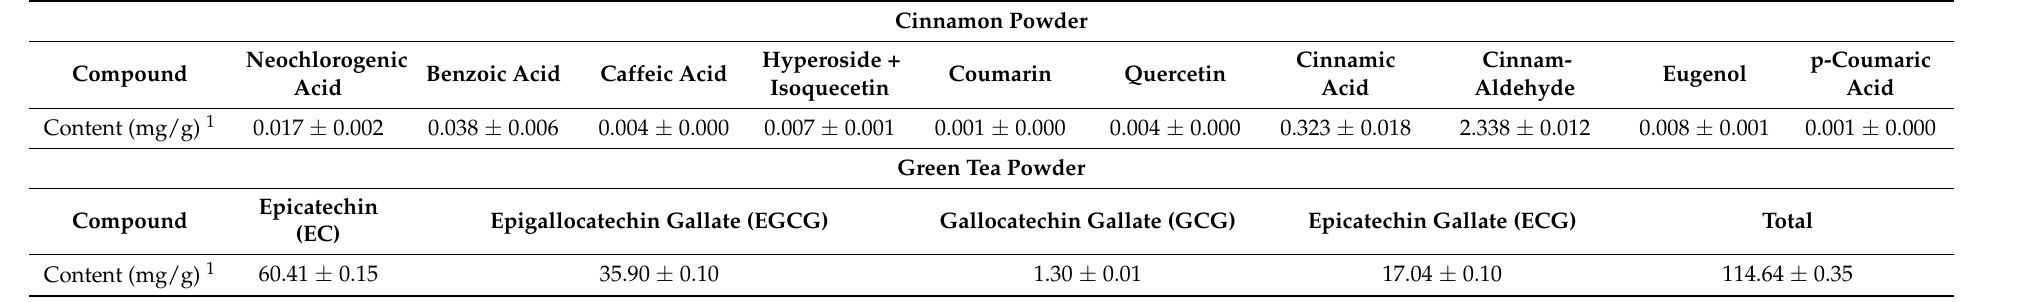
Table 5. Analysis of the bioactive compounds (mg/g) in curcuma powder and cinnamon